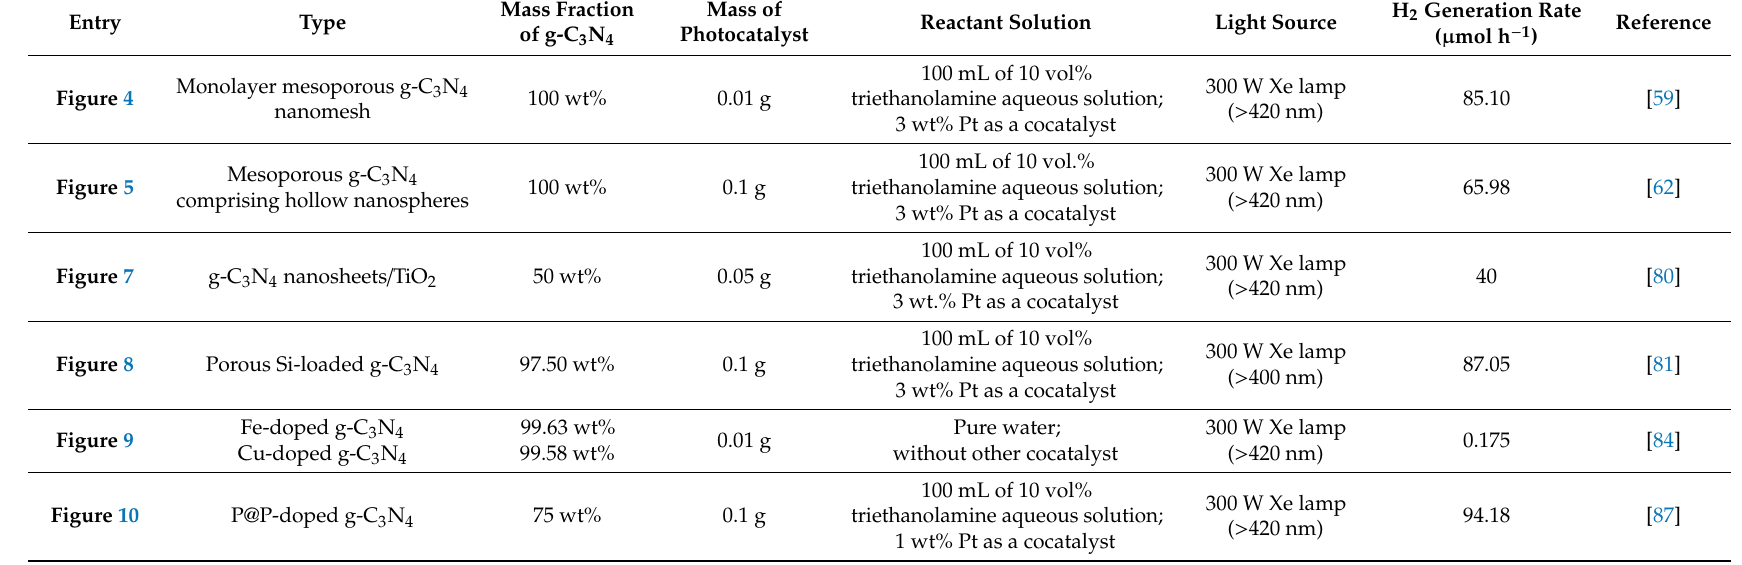
Table 1. Photocatalytic H 2 generation of g-C 3 N 4 -based